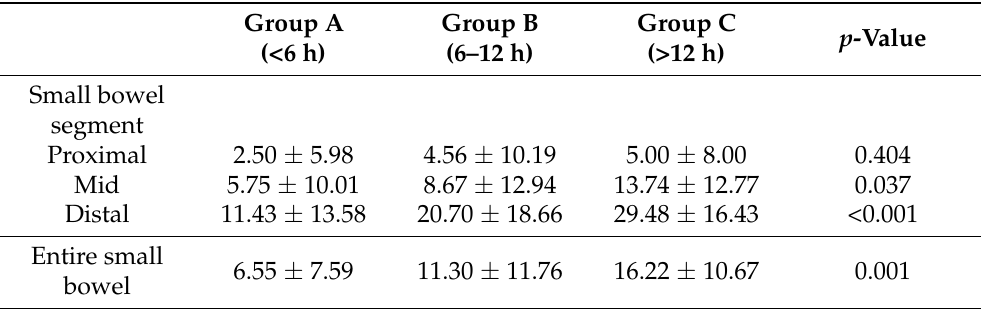
Table 4. Percentage of unclean segment in the small bowel according to the timing of bowel prepa- ration (mean % ± standard deviation).